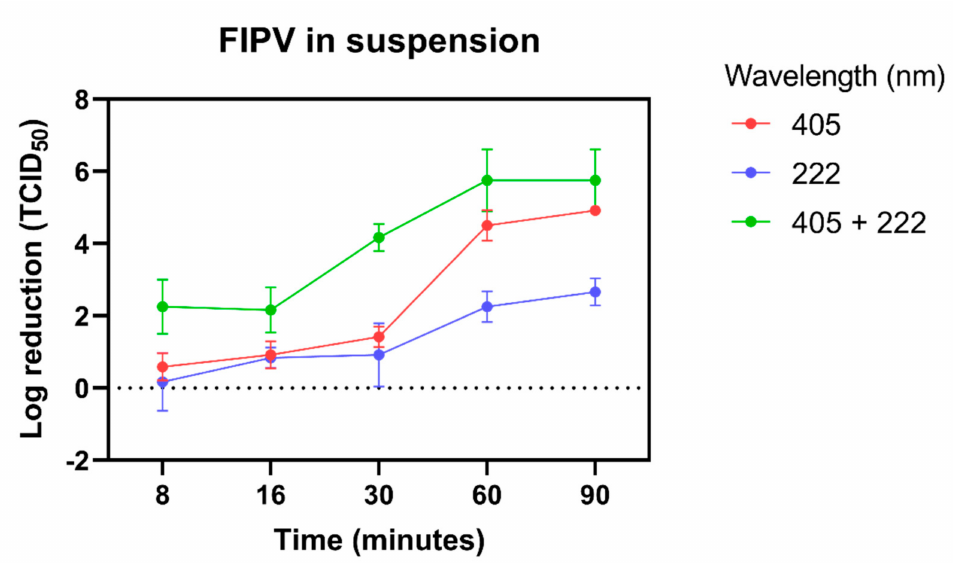
Figure 1. Inactivation of feline infectious peritonitis virus (FIPV) in growth media by blue LED 405 nm, far-UV 222 nm and dual 405 nm + 222 nm lights. All exposures were done at 25 cm distance. Error bars represent standard